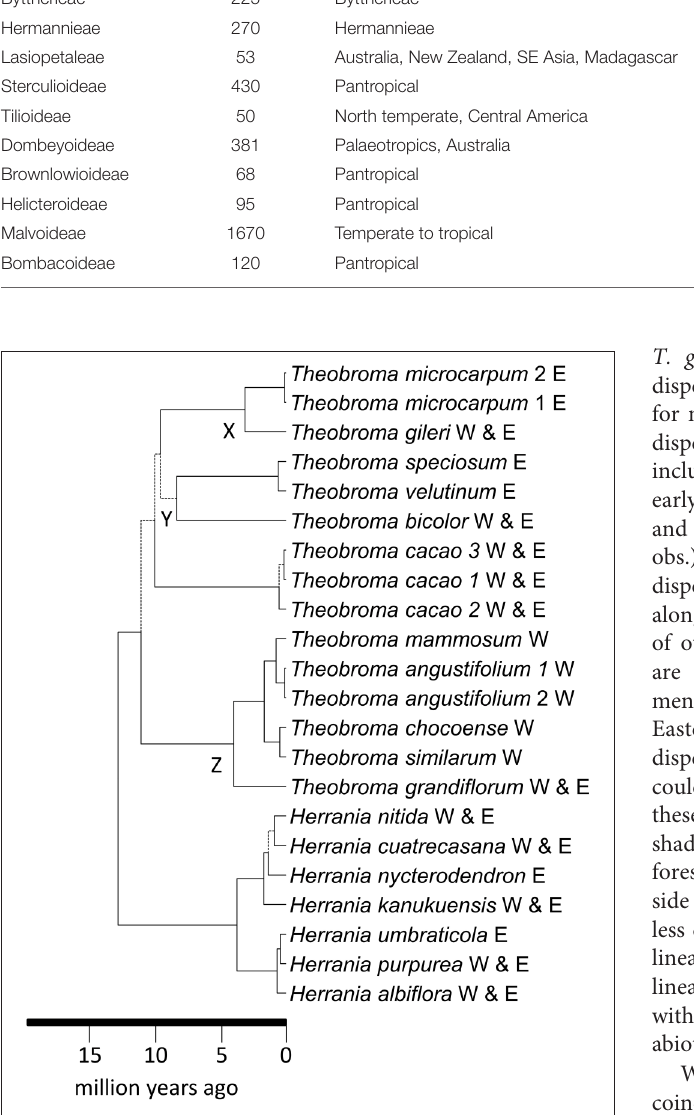
Some trans-Andean species evolved after the Andes had have been able to disperse over high mountain passes,